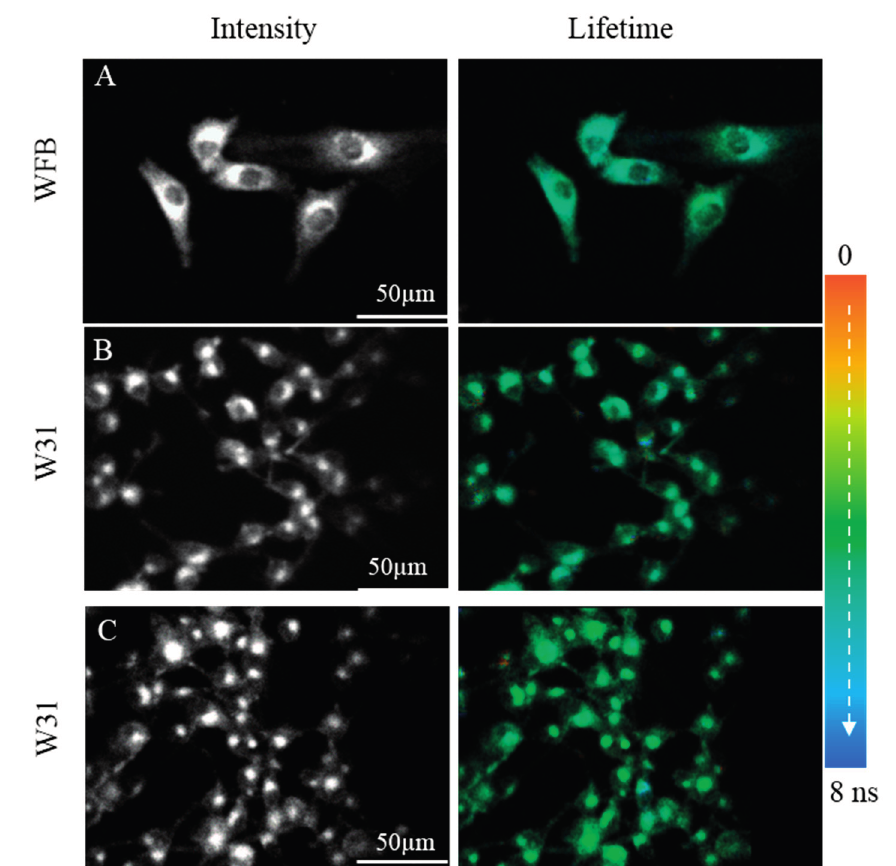
Figure 4. Fluorescence intensity images ( left ) and corresponding fluorescence lifetime images ( right ) of TPS in WFB cells ( A ) and in W31 cells ( B , C ). The image C was measured with a delay after photoirradiation rather than the image B. Pseudocolor is used for the lifetime images to show the value of the fluorescence lifetime.